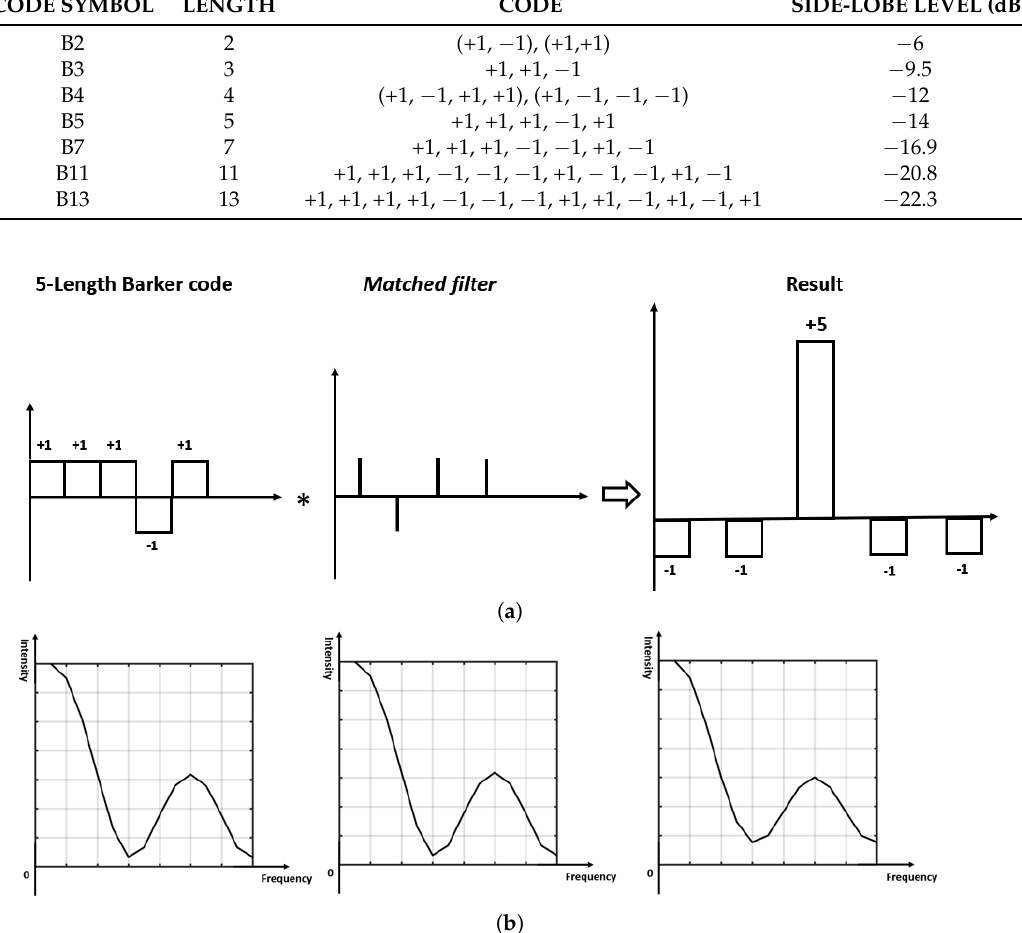
Figure 1. Illustration of 5-bit Barker code compression. ( a ) A pulse compression example of 5-bit Barker code compression. ( b ) Frequency response of the 5-bit Barker code, matched filter and compressed